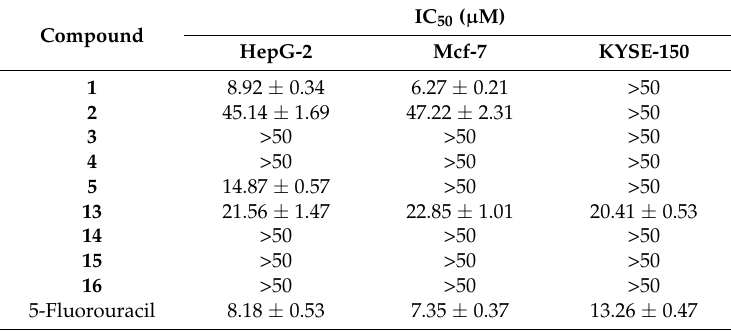
Table 3. Cytotoxicities of compounds 1 – 5 and 13 – 16 against MCF-7, HepG-2 and KYSE-150 cell lines (IC 50 , µ